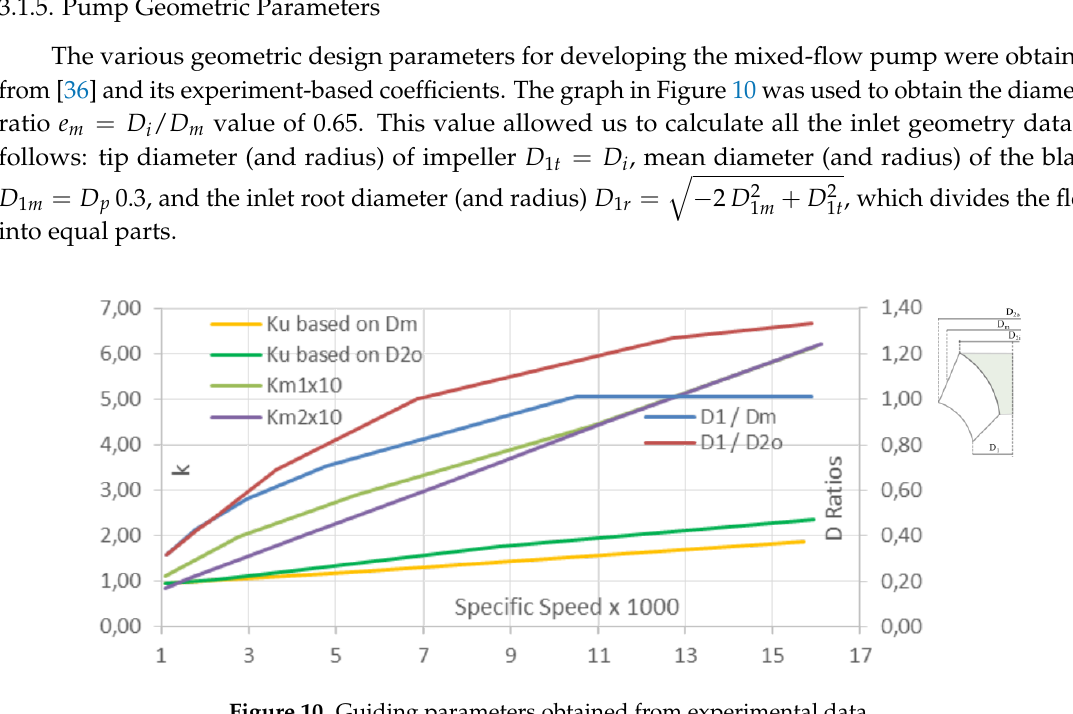
Figure 10. Guiding parameters obtained from experimental